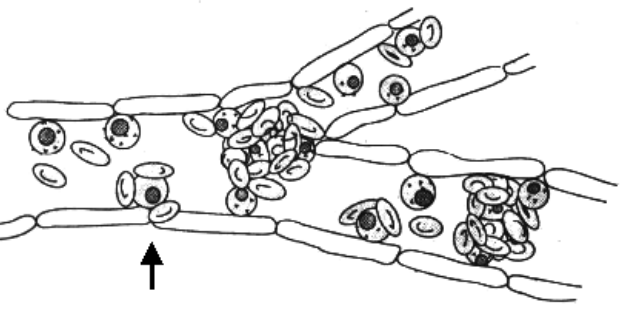
Fig. 2 – Schematic representation of rosetting and cytoadherence leading to vessels obstruction. Parasites inside red blood cells are depicted as black circles. Arrow shows an infected red blood cell involved in both cytoadherence and rosetting (Adapted from Wahlgren et al. 1992).